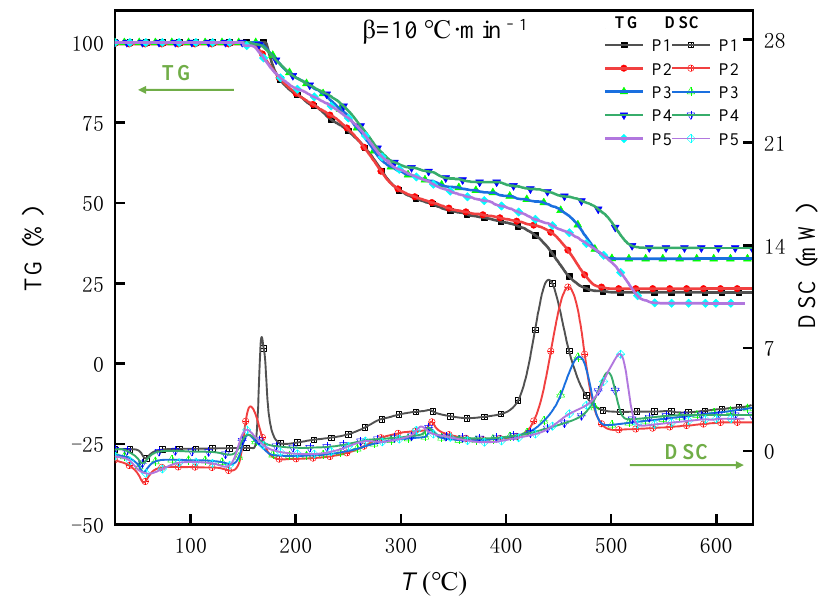
Figure 9. The TG-DSC curve of Samples P1 – P5 at β = 10 °C·min − 1 .